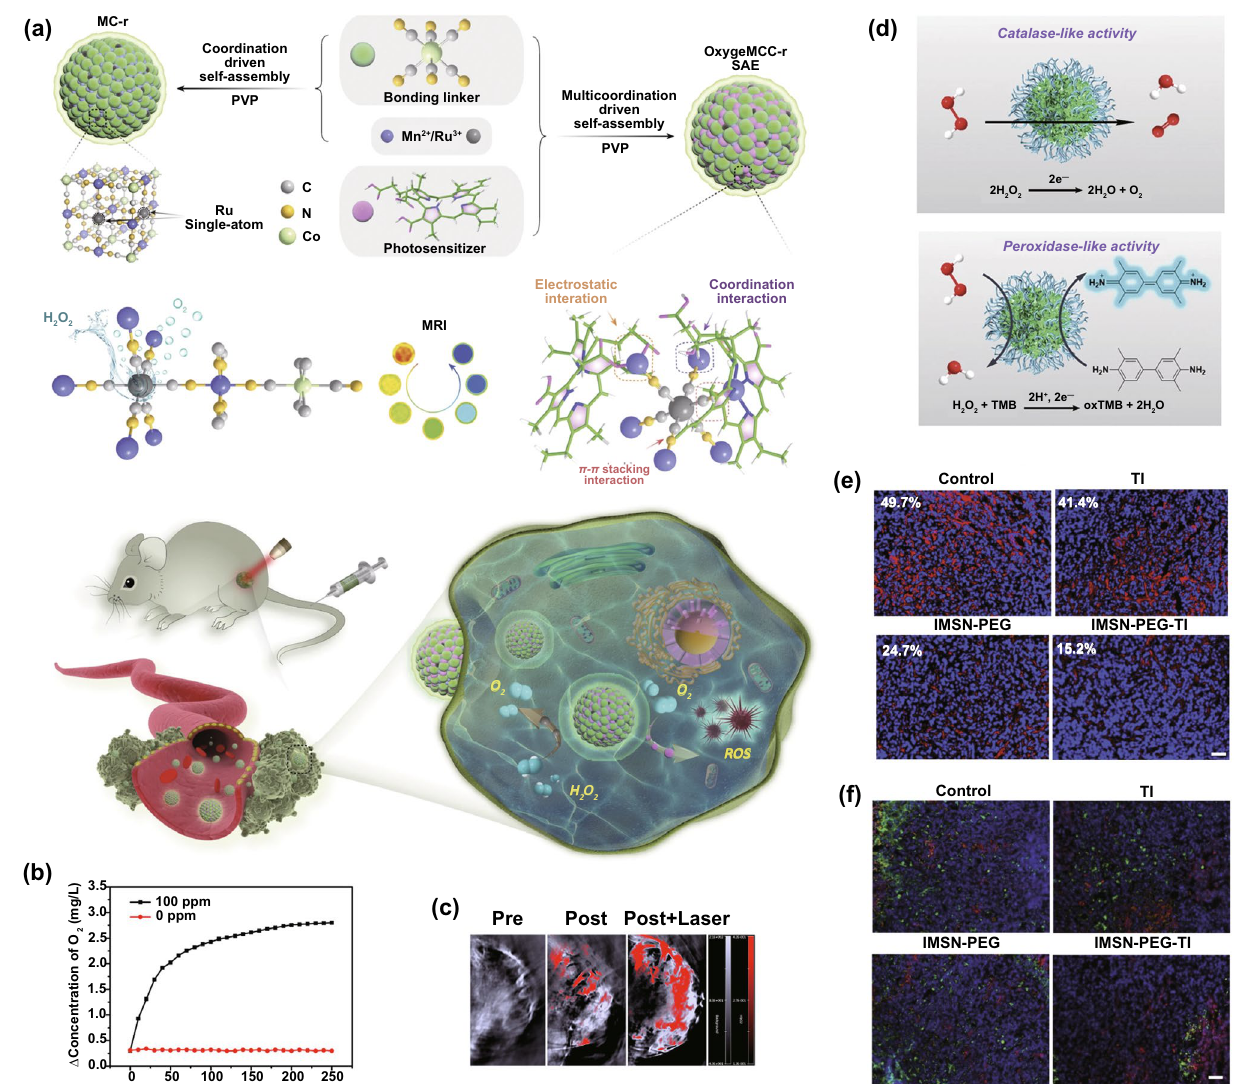
Fig. 12 a Schematic illustration of the OxgeMCC-r nanozyme with CAT-activity to oxygen self-supply PDT. Reproduced with permission from [38]. Copyright Nature Publishing Group 2020. b O 2 production ability of Pt-CuS in the presence of H 2 O 2 . c Blood oxygen saturation of tumors after different treatments. Reproduced with permission from Ref. [117]. Copyright 2019, American Chemical Society. d Schematic presenta- tion for the CAT- and POD-like activities of IMSNs. e Immunofluorescence images of HIF-1α in the tumor slides. HIF-1α and cell nuclei were stained by red and blue fluorescence, respectively. f Immunofluorescence images of macrophages in tumor tissues. M1 and M2 macrophages were stained by red and green fluorescence, respectively. Reproduced with permission from Ref. [138]. Copyright 2020, WILEY–VCH